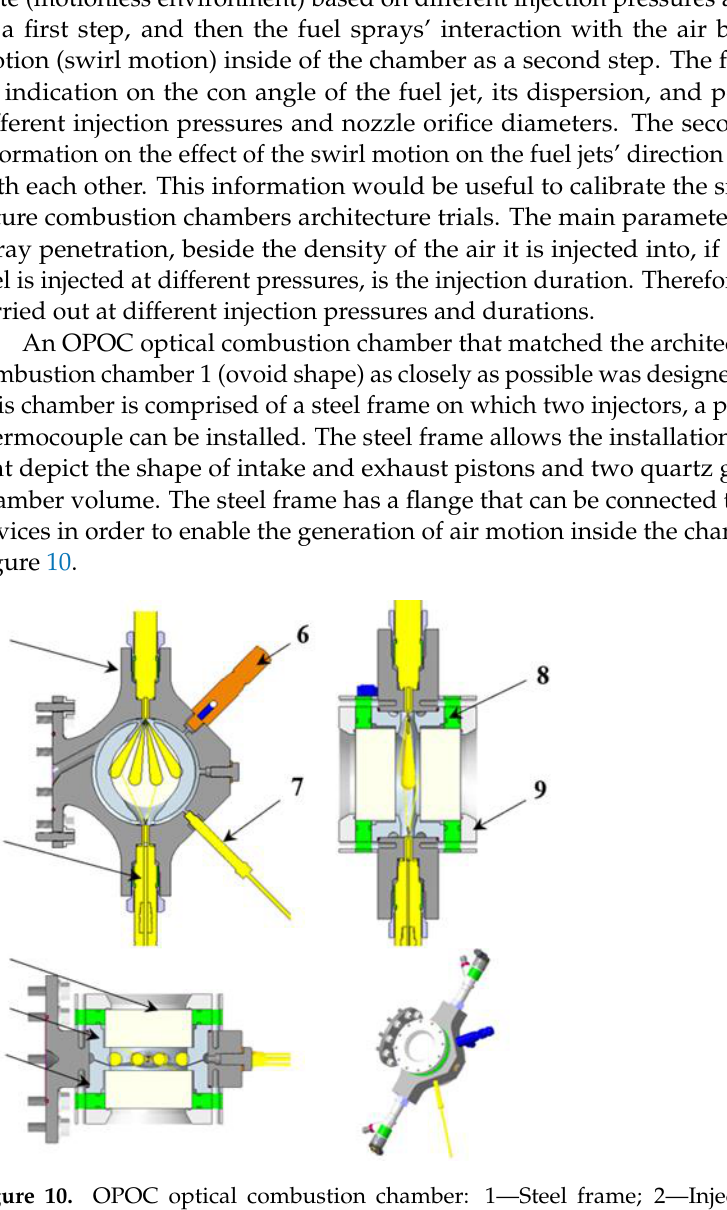
Figure 11. Preheating chamber and OPOC optical combustion chamber assembly: 1 — Preheating chamber case; 2 — Glow plug; 3 — One-way valve; 4 — Tangential channel for the swirl generation; 5 — Temperature sensor.